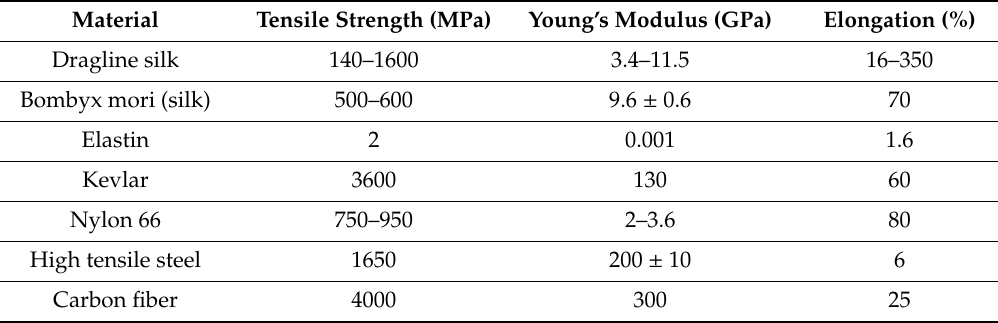
Table 2. Mechanical properties of natural and human-made